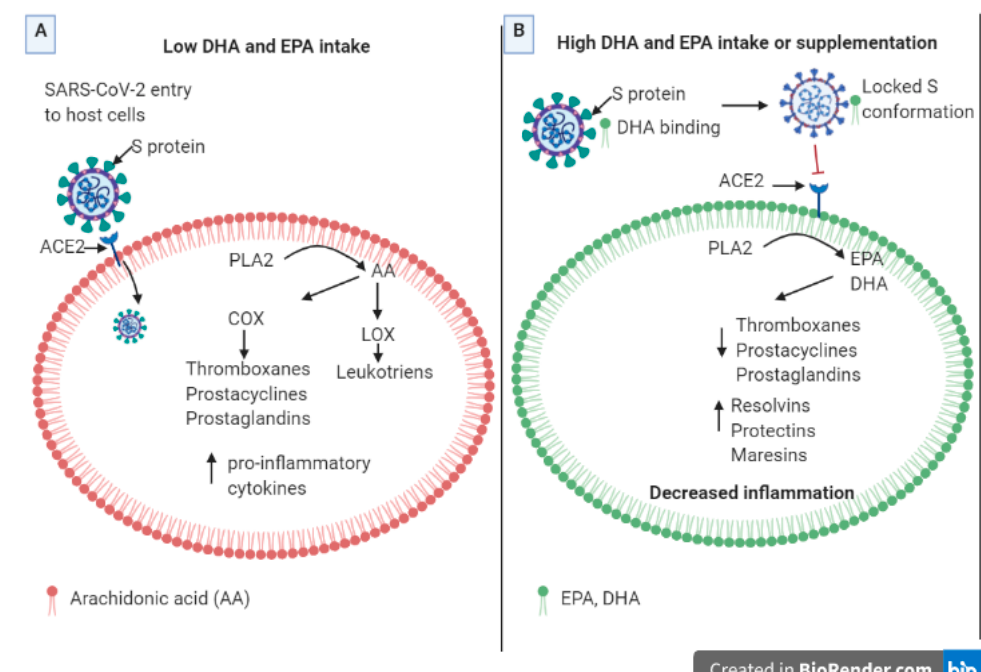
Figure 3. Potential role of docosahexaenoic acid (DHA), eicosapentaenoic acid (EPA), and other ω -3 PUFA in reducing COVID-19 infection and complications. ( A ) With a low intake of omega-3 fatty acids, such as EPA and DHA, SARS-CoV-2 mediates infection to host cells through an interaction of S-protein and ACE2. Membranes of immune cells would have a higher proportion of arachidonic acid (AA), instead of EPA and DHA, leading to the production of inflammatory eicosanoids and pro-inflammatory cytokines. ( B ) With a high dietary intake or supplementation of EPA and DHA, these omega-3 fatty acids could bind to the S-protein of SARS-CoV-2, locking it in an inactive conformation and preventing the interaction of S-protein with ACE2 and, therefore, the infection of the virus. Membranes of immune cells have a higher proportion of omega-3 acids rather than omega-6 acids, activating the production of inflammation resolving mediators, such as resolvins, protectins, and maresins, and producing fewer pro-inflammatory cytokines. These would lead to a decreased inflammation and a more efficient resolution of this process.